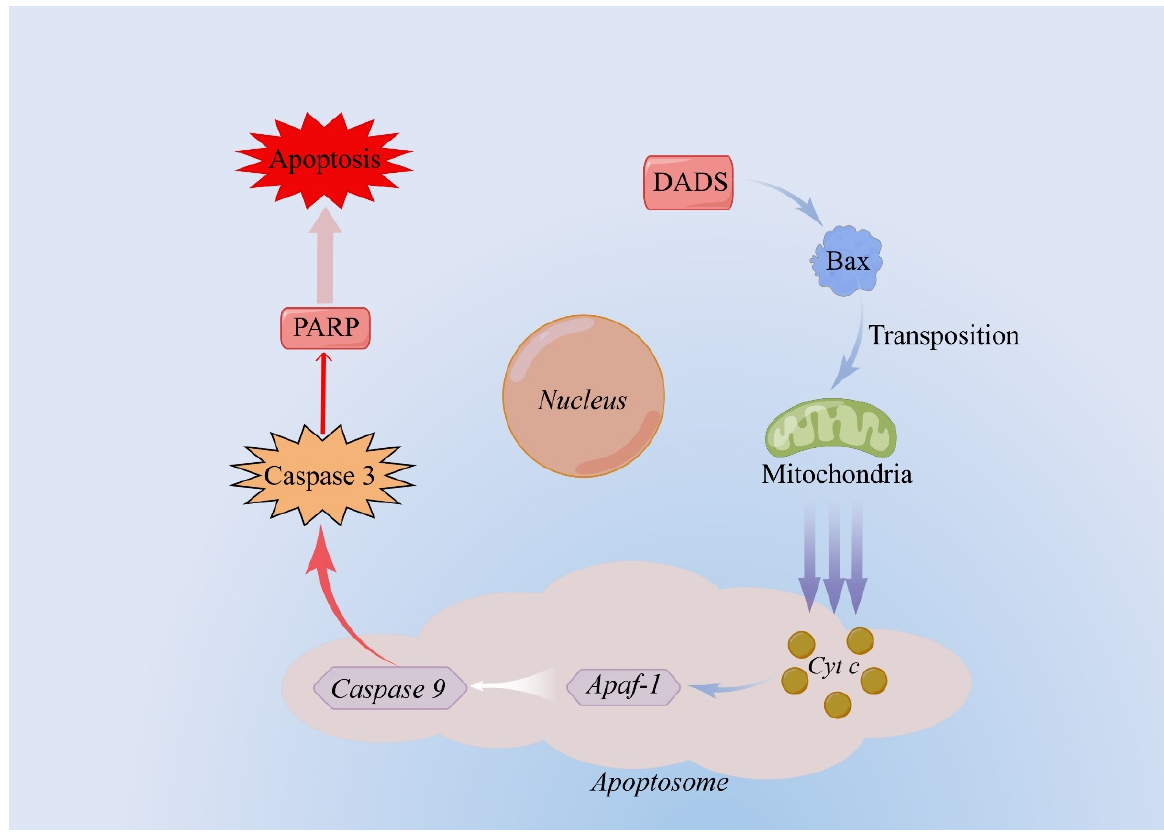
Figure 4. The molecular mechanism of apoptosis induced by DADS. DADS stimulates the translo- cation of pro-apoptotic protein Bax from cytoplasm to mitochondrial membrane, which increases the permeability of mitochondrial membrane and promotes the release of cytochrome C from mitochondria. Apoptotic enzyme activator binds with cytochrome C to form a polymer, and Caspase-9 is recruited and processed to form an apoptotic complex. Finally, the downstream apoptosis factor Caspase-3 is activated, which leads to apoptosis. Abbreviations: DADS: diallyl disulfide. (By